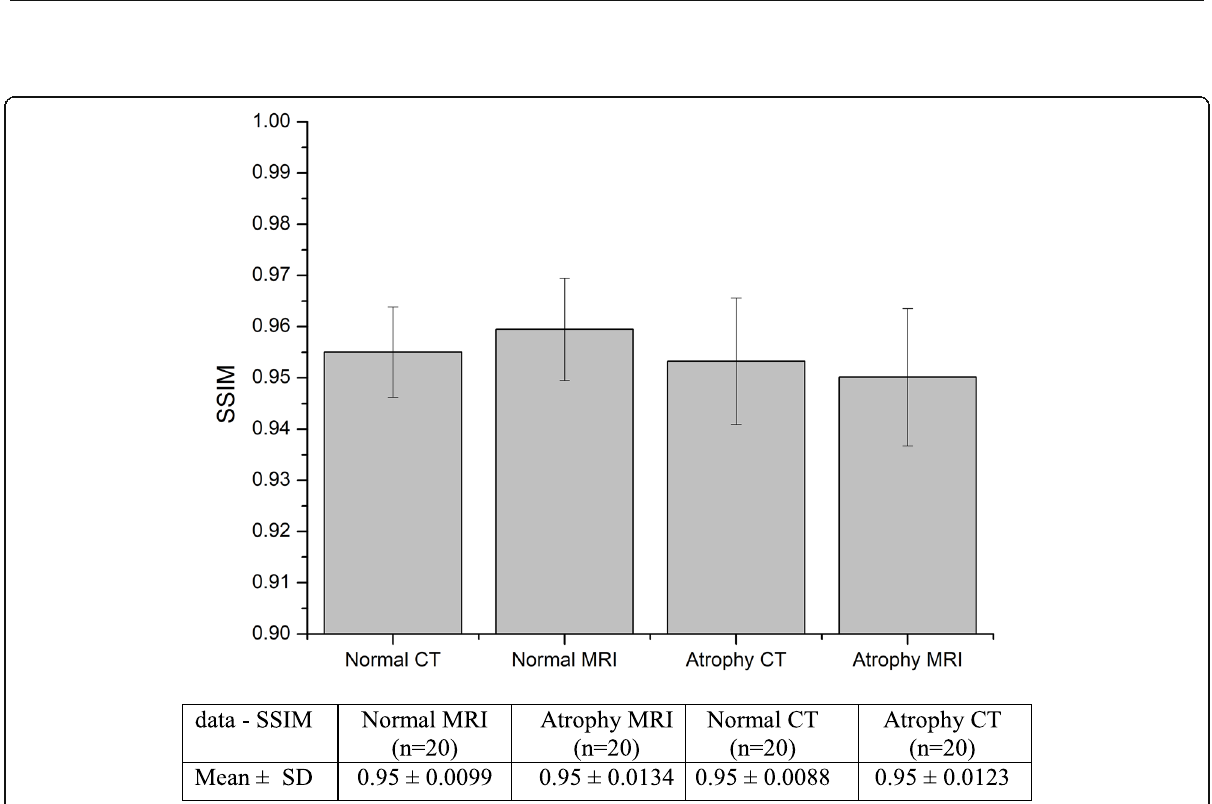
Fig. 10 Results of SSIM calculated between ground truth and segmented images for CT and MR